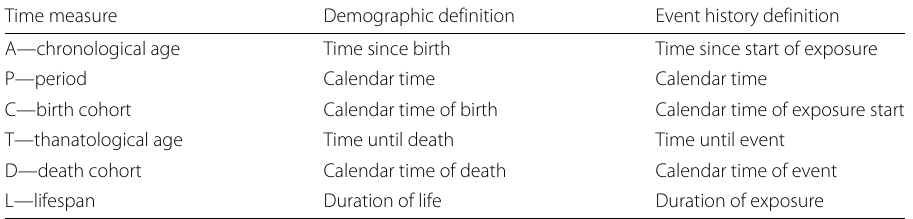
Table 1 Definitions of the six time